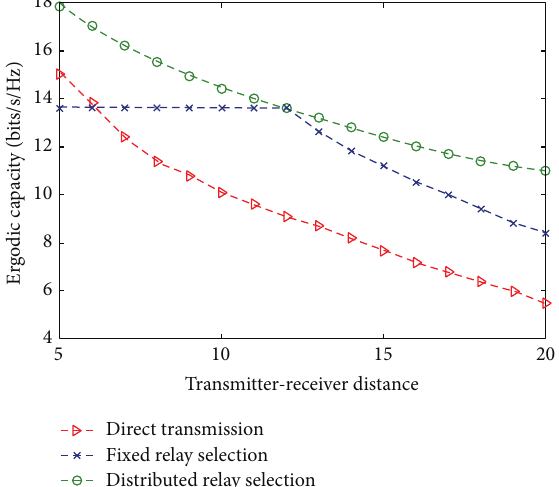
Figure 15: Average flow throughput in multihop scenario.